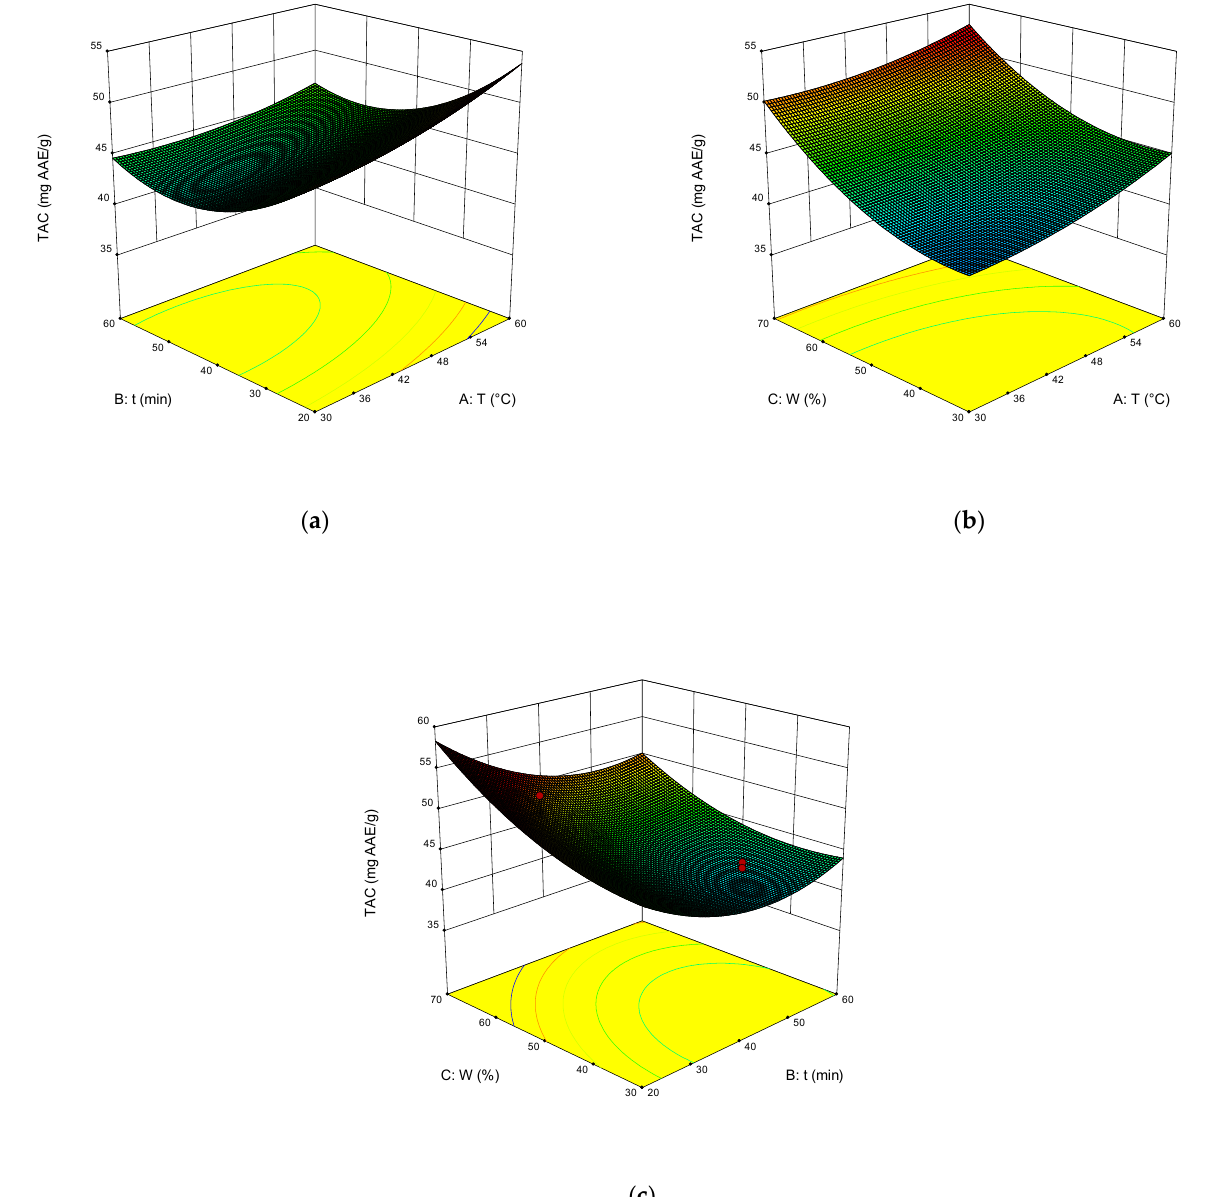
Figure 6. Response contour plots ( a – c ) showing the extraction temperature (A), extraction time (B), and water content (C) effect on the extraction yield of TAC.